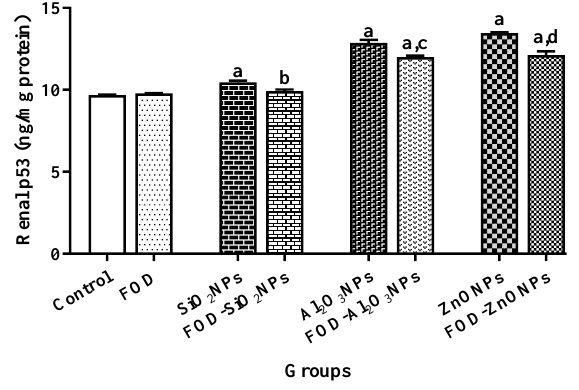
Fig. 3. The effects of fig with olive oil and date-palm fruit extracts (FOD) on the renal tumor suppressor p53 (p53) in rats treated with different nanoparticles (NPs) for 75 days. a p<0.05, versus control group; b p<0.05, versus SiO 2 NPs; c p<0.05, versus Al d p<0.05, versus ZnONPs. N.B: 2 O 3 NPs; The antioxidants (FOD) treatments were used for 2 weeks before and during the administration of the